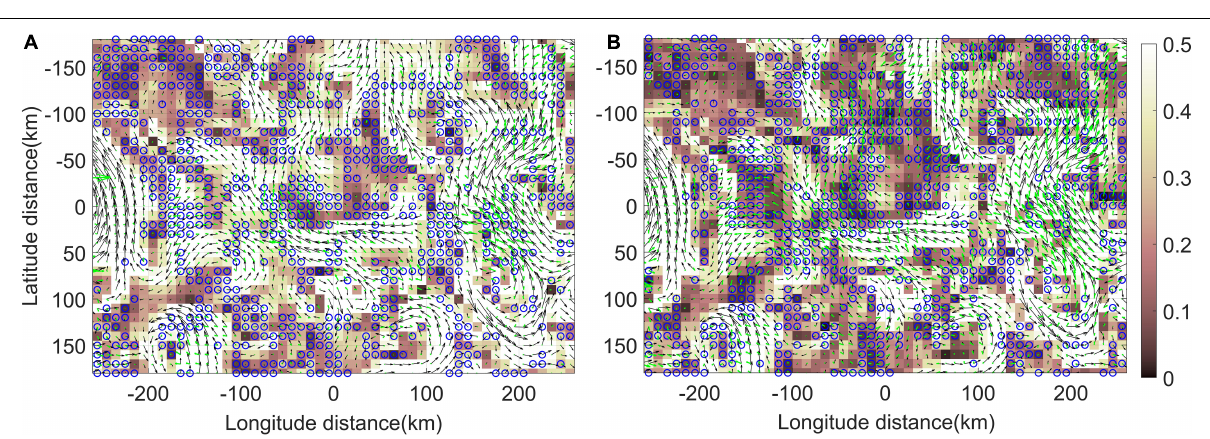
Frontiers in Marine Science |